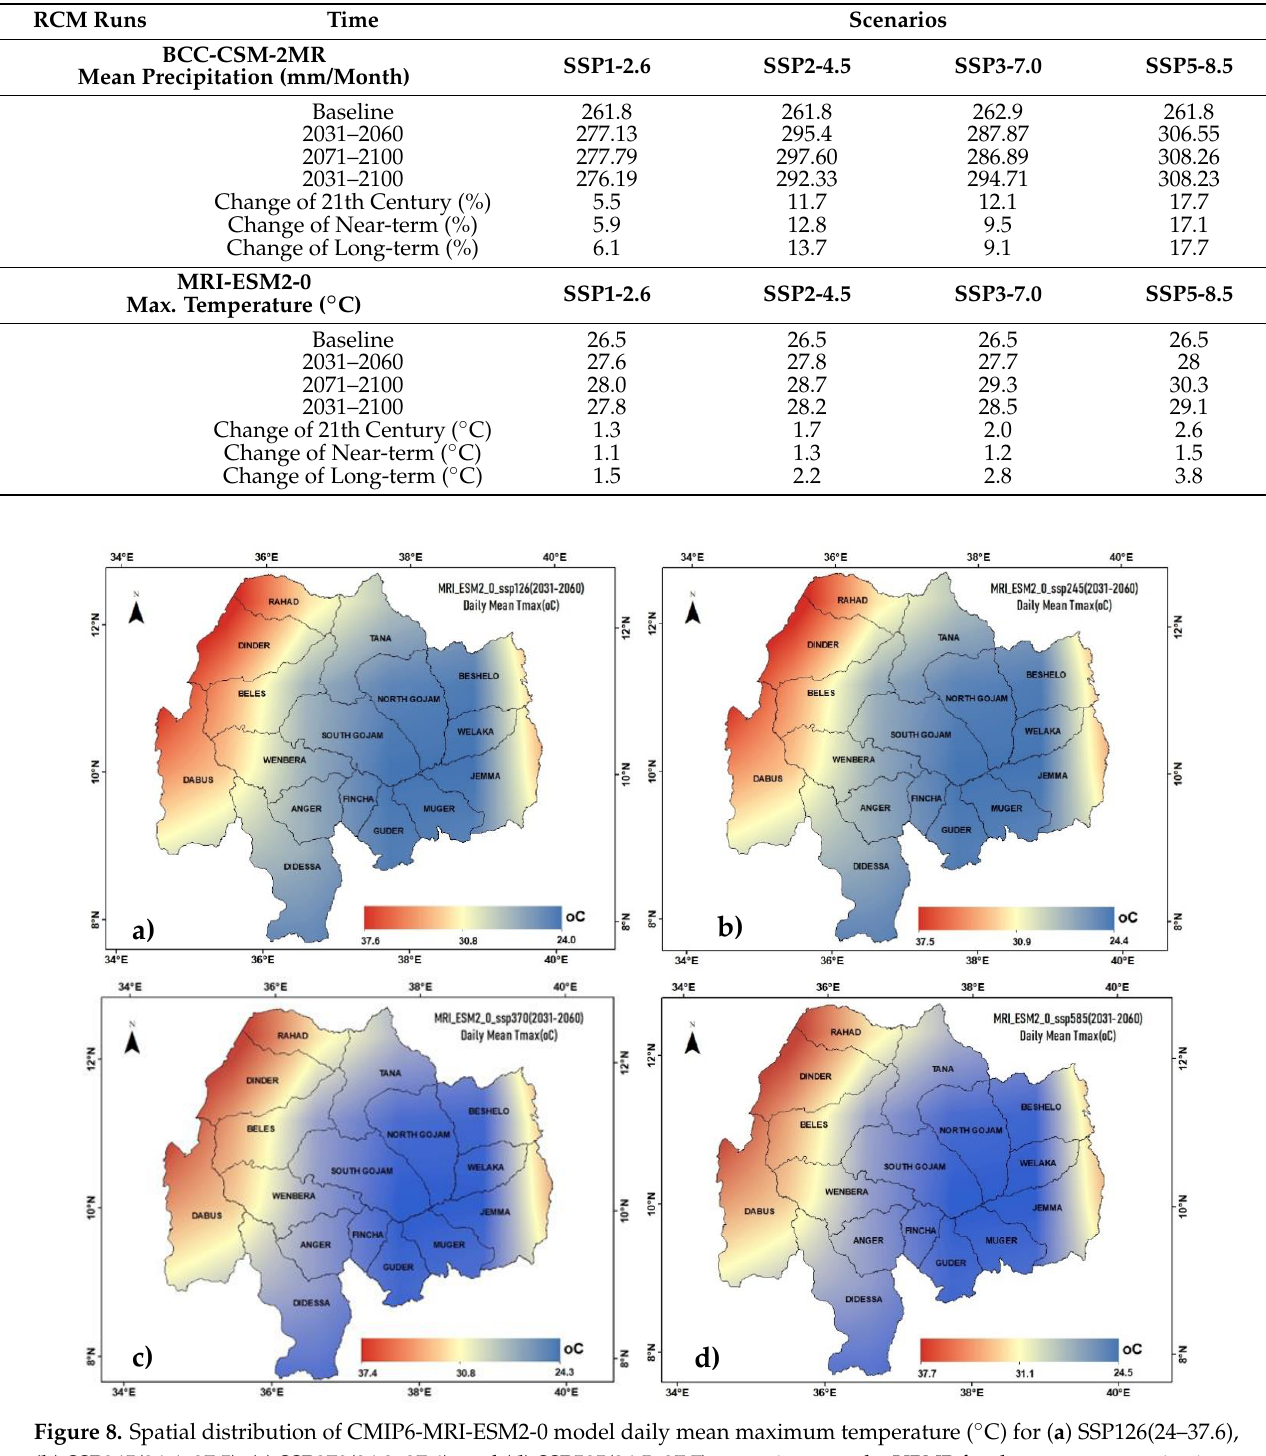
Table 4. Changes in mean annual maximum temperature and mean annual precipitation by the end of century (2071–2100) relative to the baseline period (1981–2010) in the UBNB ( Abay ).